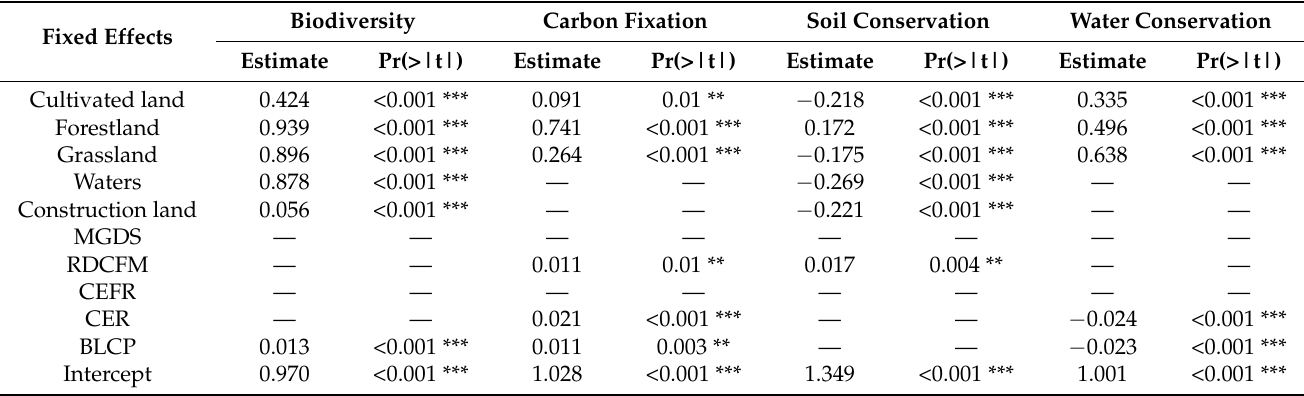
Table 3. Results of GAM characterizing the relationships between ESs and fixed effects. Fixed